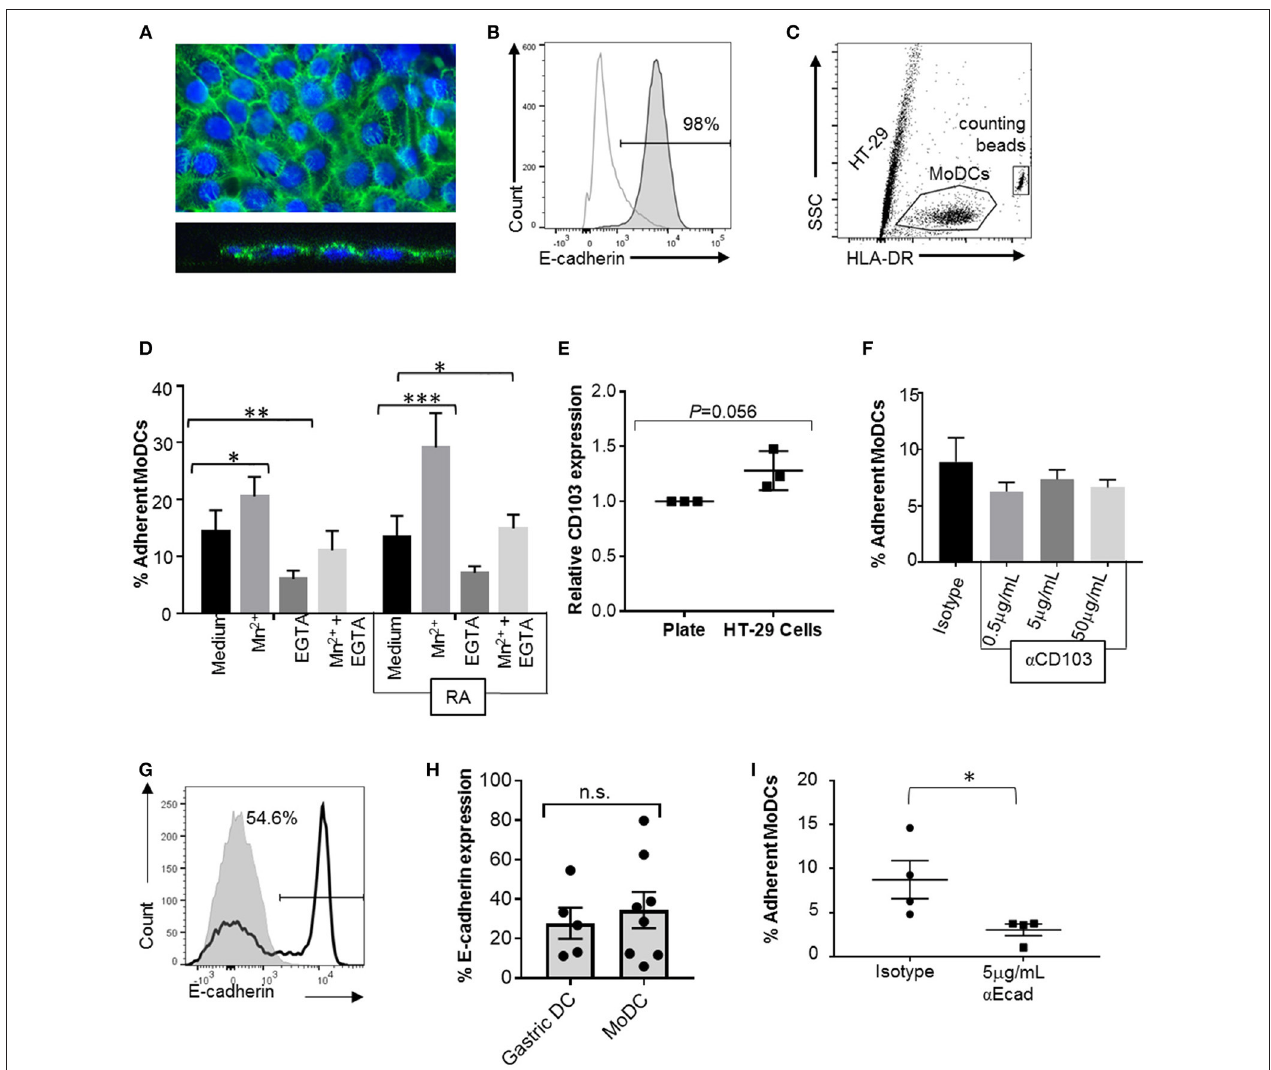
FIGURE 7 | CD103 is not a major mediator of DC adhesion to E-cadherin-expressing epithelial cells. To analyze MoDC binding to E-cadherin expressed by epithelial cells, MoDCs were added to confluent monolayers of HT-29 cells for 2h. Non-adherent cells were then removed by gentle washing, the remaining cells were collected by trypsinization, and the number of adherent DCs was determined using counting beads and HLA-DR-labeling of the DCs. (A) Confocal analysis of an HT-29 monolayer shows E-cadherin expression on the luminal surface. Top panel: maximum Z-projection; bottom panel: orthogonal view. Nuclei are labeled with DRAQ5 (blue). (B) Representative FACS histogram of E-cadherin expression on HT-29 cells. Gray line: isotype control; dark gray filled: anti-E-cadherin. (C) Gating strategy for counting adherent MoDCs following co-culture with HT-29 cells. (D) Percentage of MoDCs adherent to HT-29 cells in the presence of Mn 2 + , EGTA, or Mn 2 + + EGTA ( n = 6). RA indicates that cells were derived in the presence of 100nM RA. * P ≤ 0.05, ** P ≤ 0.01, *** P ≤ 0.001; 2-way ANOVA with Dunnett’s multiple comparisons. (E) Normalized CD103 expression on MoDCs after recovery from HT-29 co-cultures (with Mn 2 + ). Data from three independent experiments, paired, one-tailed Student’s t -test. (F) MoDCs were incubated with an isotype control antibody or the indicated concentrations of anti-CD103 antibody before and during co-culture with HT-29 cells, and the number of adherent DCs was determined. N = 3, * P ≤ 0.05; unpaired, two-tailed T -test. (G,H) representative histogram and pooled data for E-cadherin expression on human gastric ( n = 5) and MoDCs ( n = 8). (I) MoDCs were treated with anti-E-cadherin antibody before and during co-culture with HT-29 cells, and the number of adherent DCs was determined. N = 4, * P ≤ 0.05; unpaired, two-tailed Student’s t